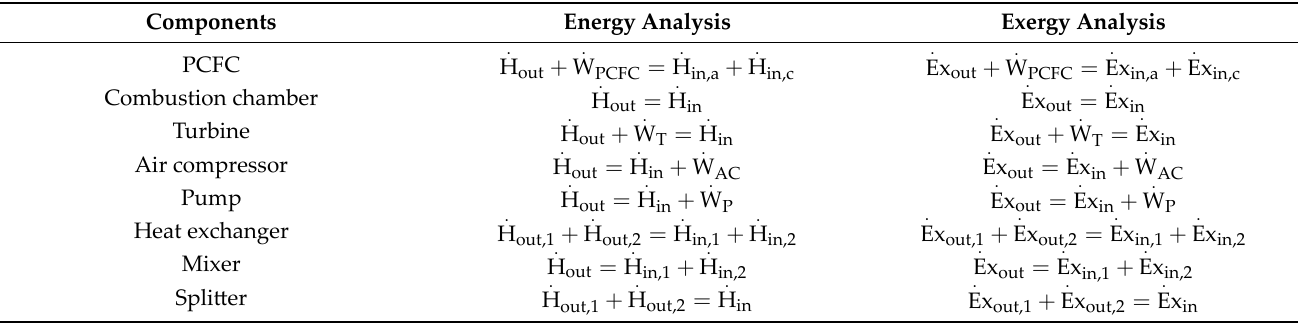
Table 2. Energy and exergy analysis of the components used in PCFC/GT hybrid